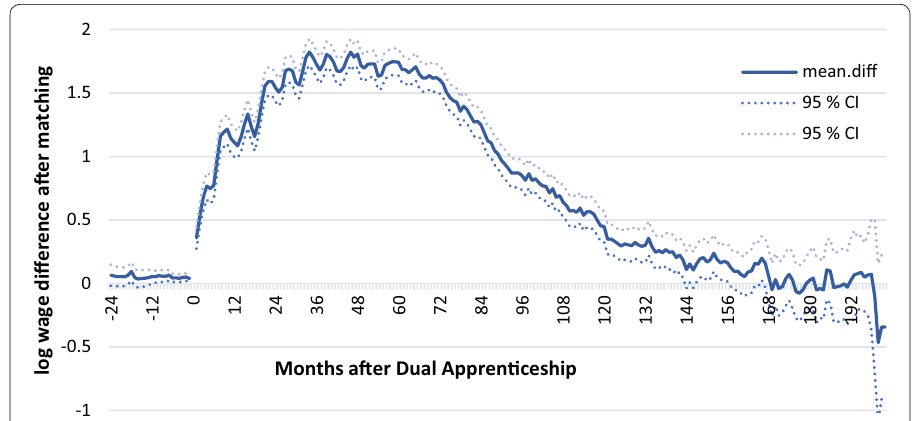
Fig. 3 Earnings differences between matched vocationally and academically educated people after completed apprenticeship (N 2079 matched =